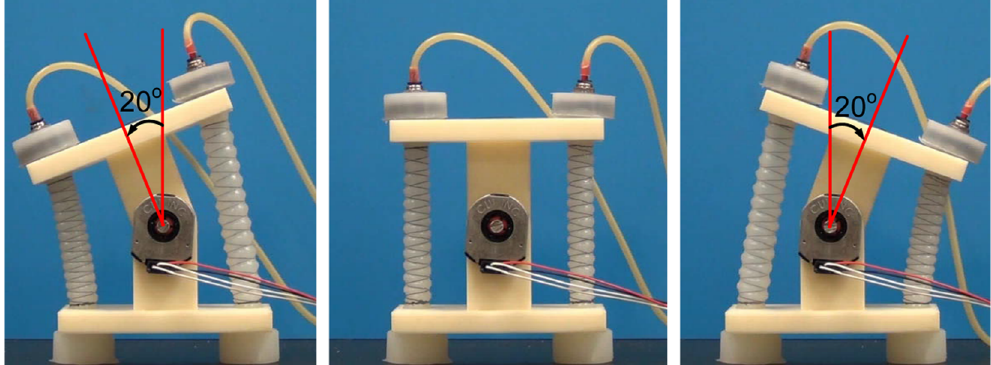
Figure 14. CAD model (Left) compared to prototype of a reverse pneumatic artificial muscle (rPAM) [12] (Open Access). Actuators 2020 , 9 , 3 14 of 27